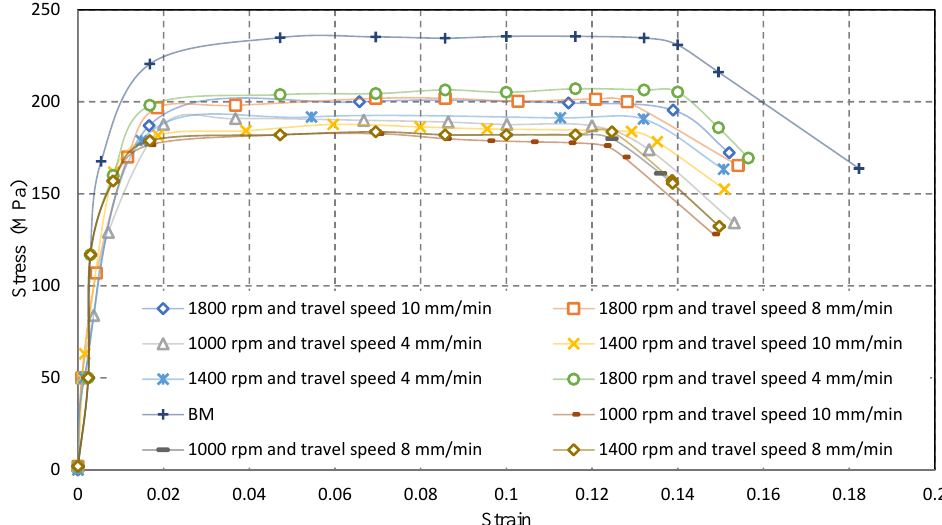
Figure 7. Stress – strain curve of welded 6063 T-6 joints (2 kN axial force). BM is base metal.